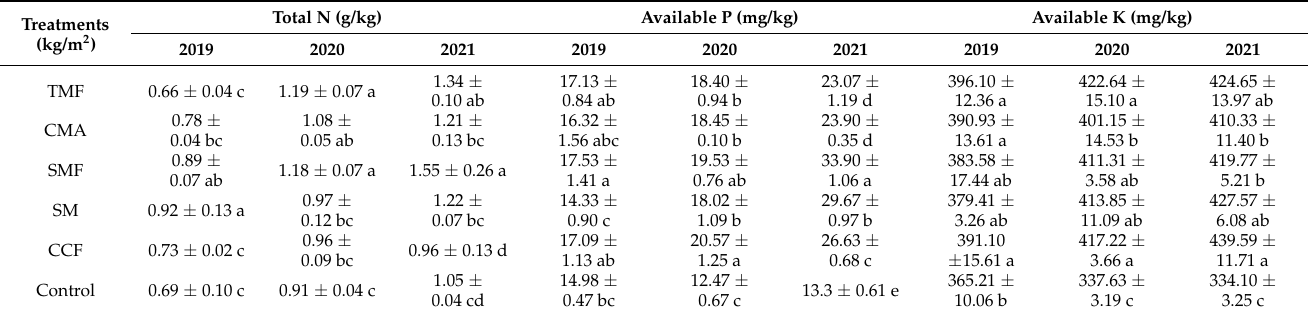
Table 4. Effects of different microbial fertilizers on the total N, available P, and available K in newly reclaimed